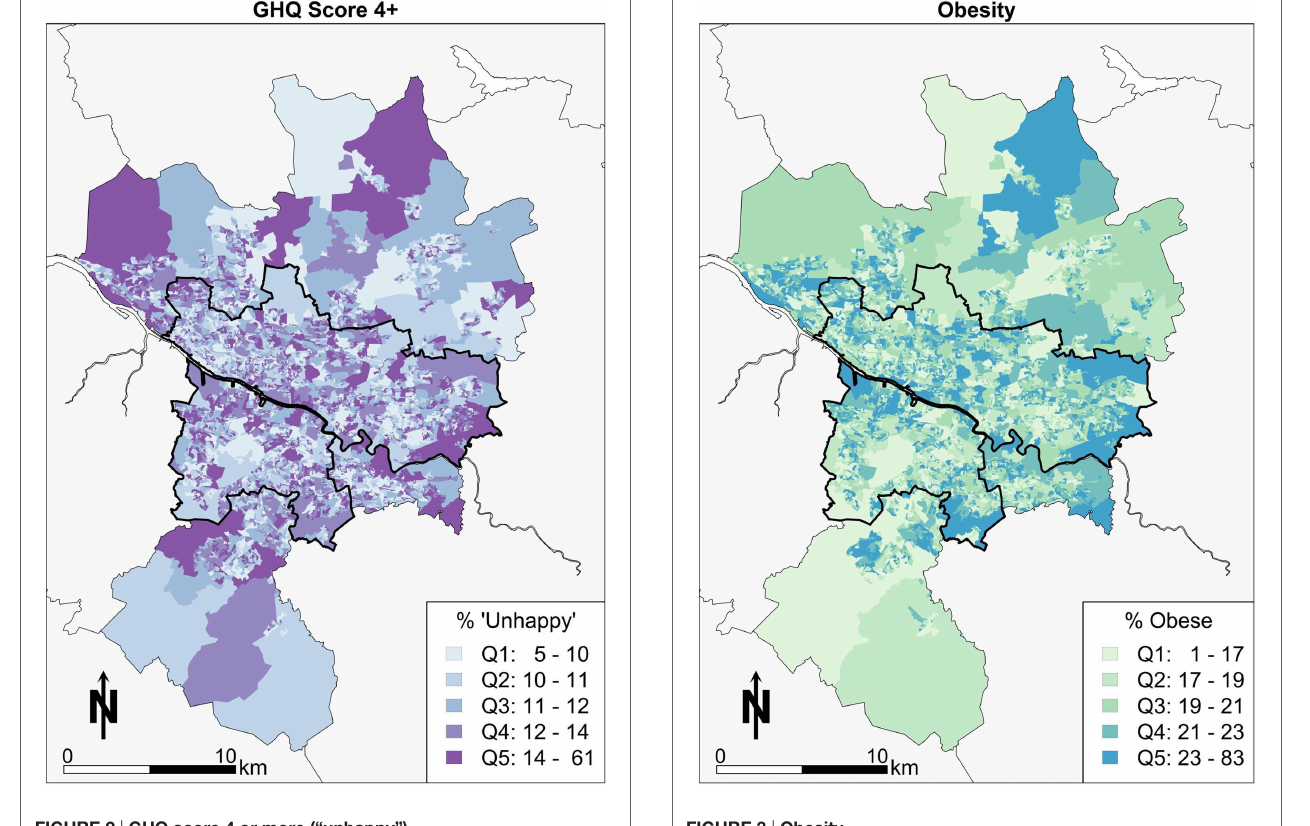
FigUre 3 | Obesity . FigUre 2 | ghQ score 4 or more (“unhappy”)